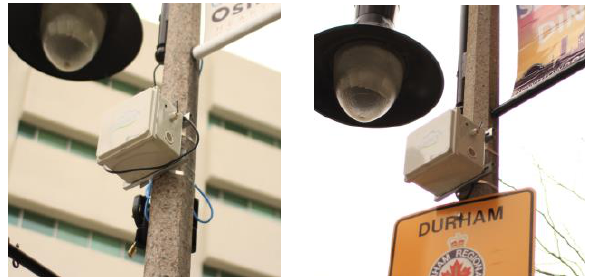
Figure 3. AirSENCE™ units in downtown Oshawa.